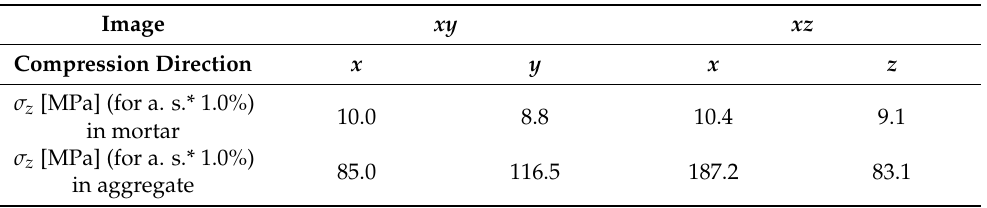
Table 8. Maximum values of the Mises equivalent stresses depend on the particular image and the compression